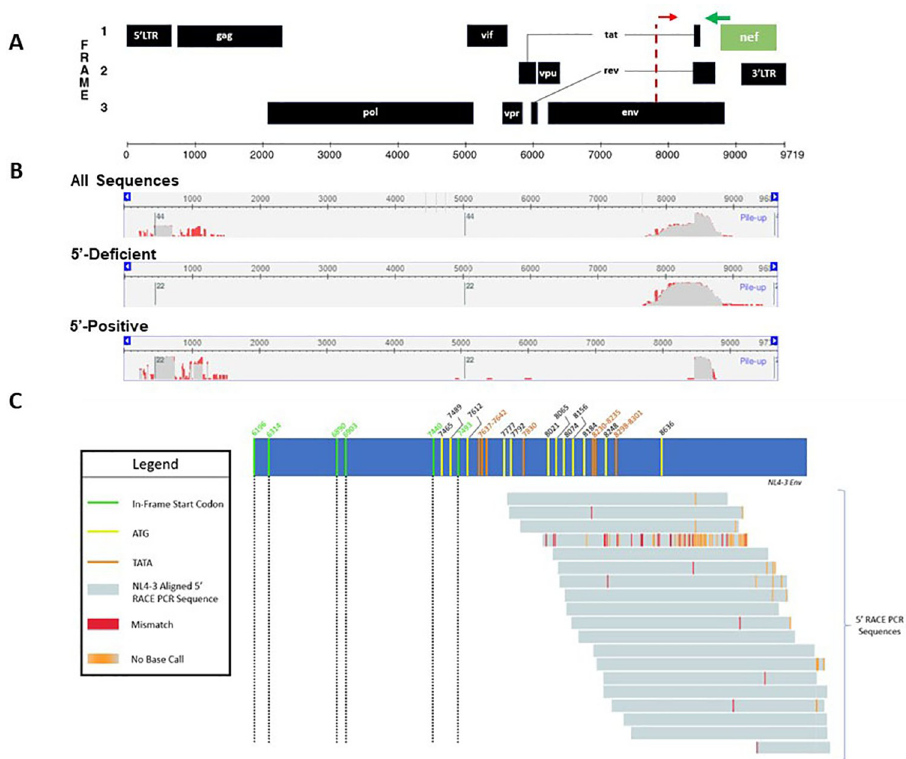
Fig 4. Sequencing of 5’ RACE PCR products identified HIV-1 transcripts with intragenic start sites. (A) Schematic of HIV-1 genome with putative promoters indicated as dotted red lines as predicated by Promoter 2.0 [33] and ElementNT V2 [34]. The green line represents the 5’ RACE gene-specific Nef primer. (B) 5’ RACE results analyzed using the NCBI Multiple Sequence Alignment Viewer. (Top) All 5’ RACE sequences aligned to NL4-3 sequence (N = 41 sequences). (Middle) 5’ RACE sequences which lacked 5’ UTR aligned to NL4-3 sequence (N = 19). (Bottom) 5’ RACE sequences which contained 5’ UTR aligned to NL4-3 sequence (N = 22). (C) Schematic alignment of 5’ RACE sequences lacking 5’ UTR sequence (gray bars, N = 19) with the NL4-3 env gene (blue bar). Green and black dotted lines indicate in-frame start codons (numbered using GenBank: AF324493.2). Yellow lines represent out of frame start codons. Orange lines (top) represent TATA box sequences. Red lines represent sequence mismatches between 5’ RACE reads and NL4-3 env . Orange lines (bottom) indicate that no nucleotide was assigned for that position during the sequencing reaction. Start codons and TATA box sequences were mapped and multiple sequence alignments were performed using Benchling Biology Software (https://benchling.com, 2021).